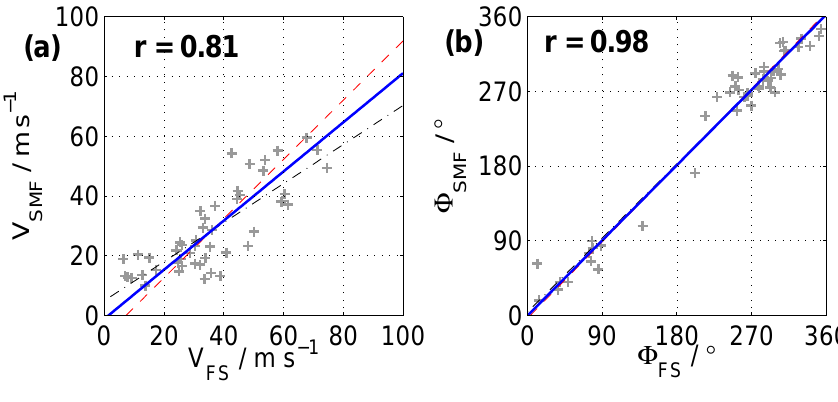
Fig. 6. Scatter plots of wind speed (a) and direction (b) from the spaced antenna experiment using the narrow-beam Saura MF radar ( V SMF ,8 SMF ) and falling spheres ( V FS ,8 FS ) for the altitude range below 80km.